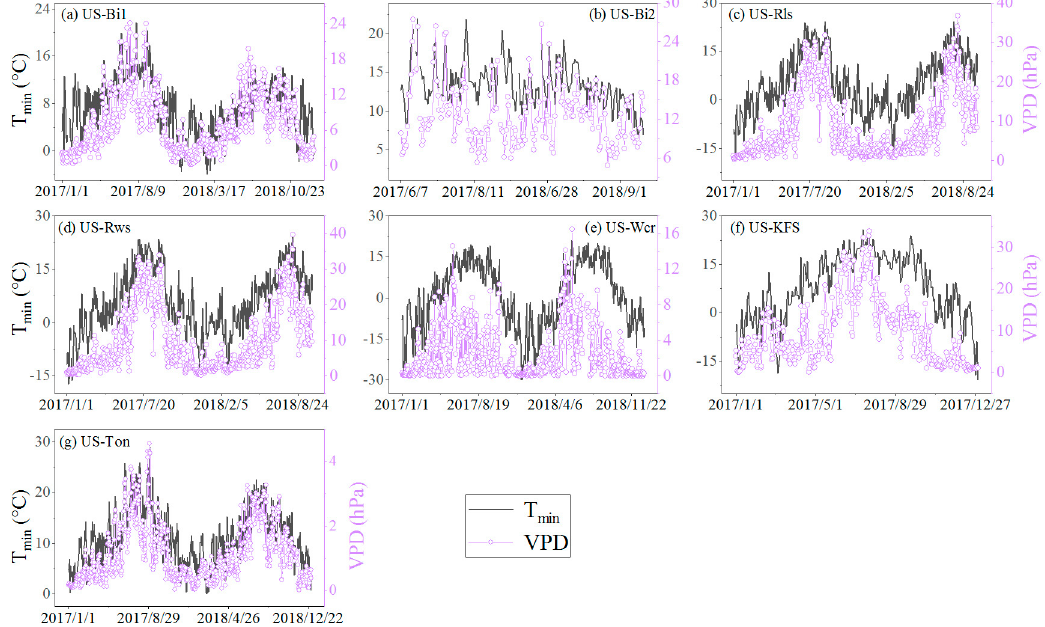
Figure 3. Temporal dynamics of the minimum temperature (T min ) and vapor pressure deficit (VPD) for all seven sites in 2017 and 2018. ( a – g ) represent the sites the same as Figure 2.